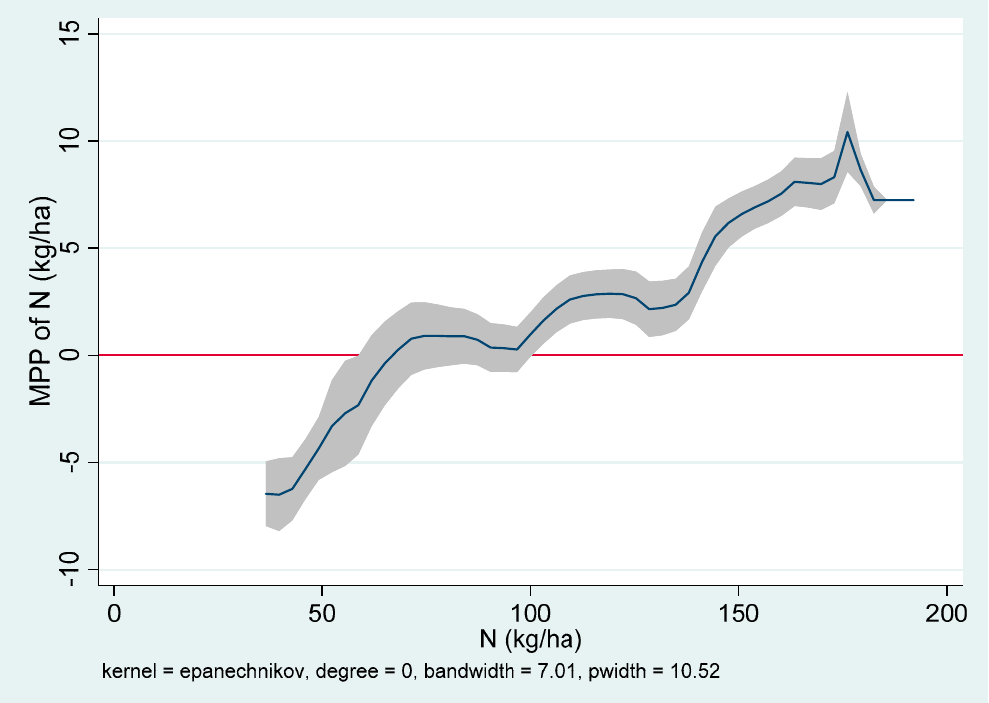
Figure 6. Marginal physical product of N at the mean level in Suphan Buri, Thailand.